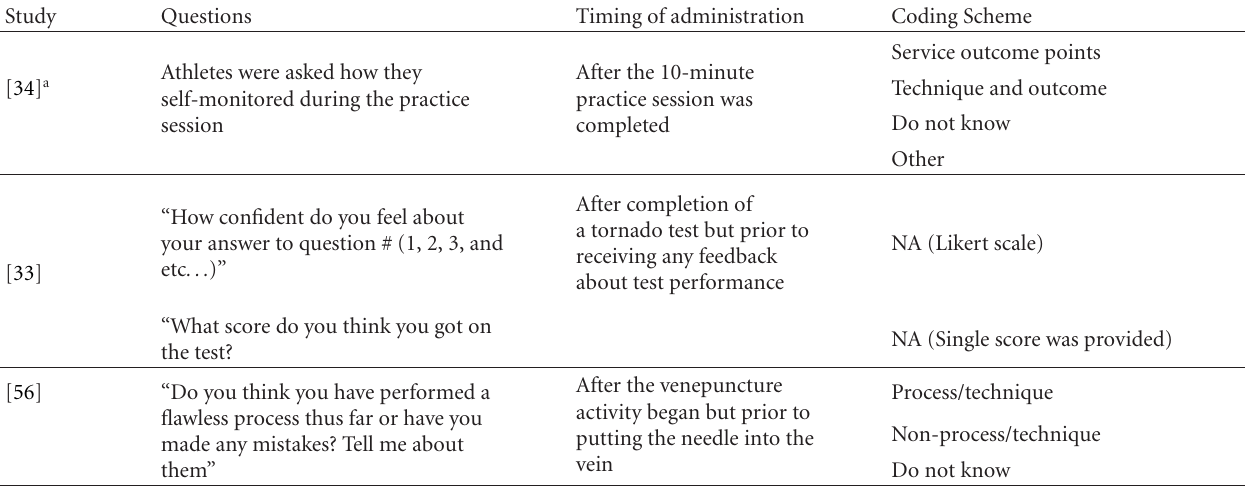
Table 4: Examples of self-observation (metacognitive monitoring), microanalytic questions, administration sequence, and coding scheme. Study